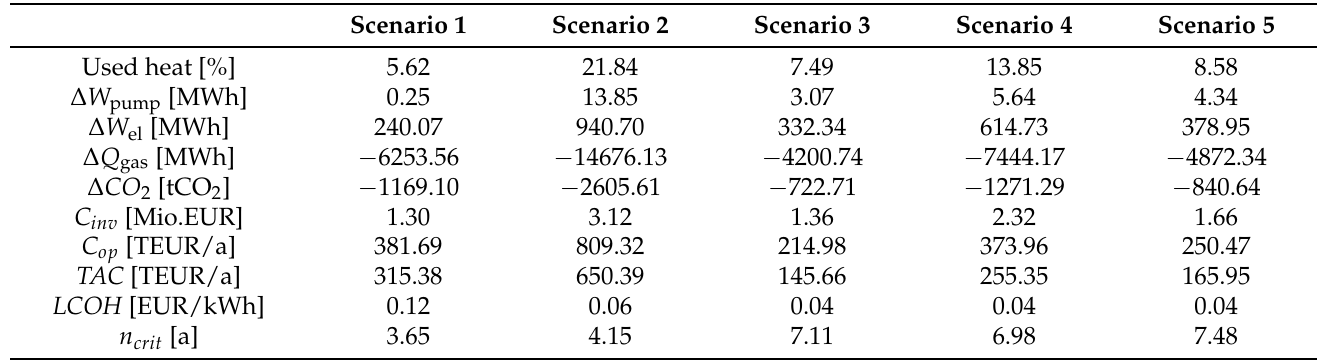
Table 5. Assessment results of all separation scenarios of the FZJ district heating system.